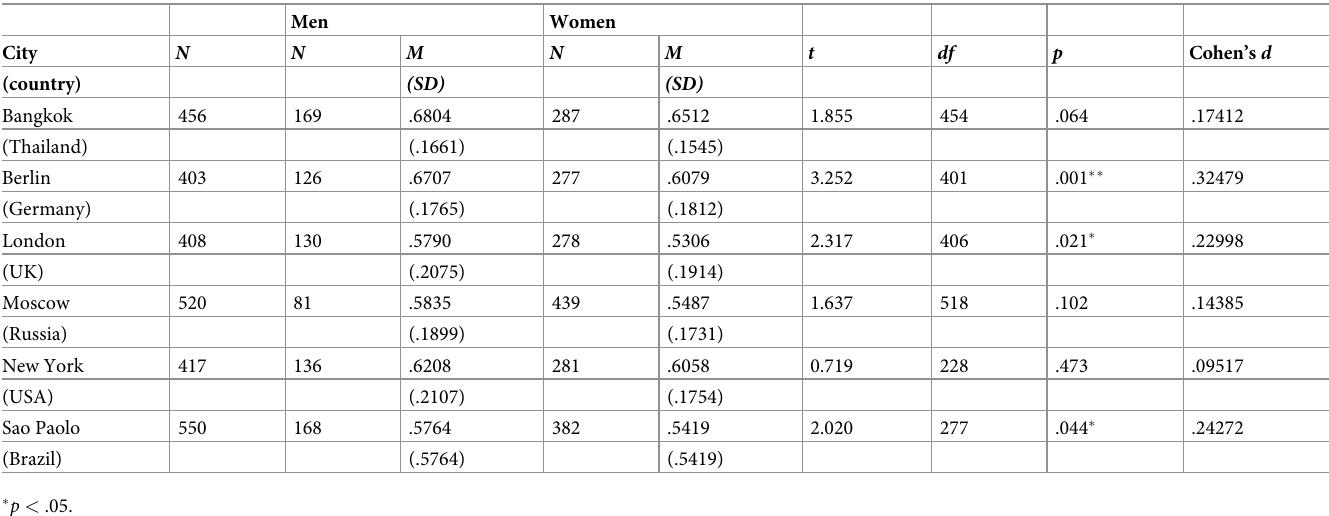
Table 1. Gender differences in face-ism index by city.